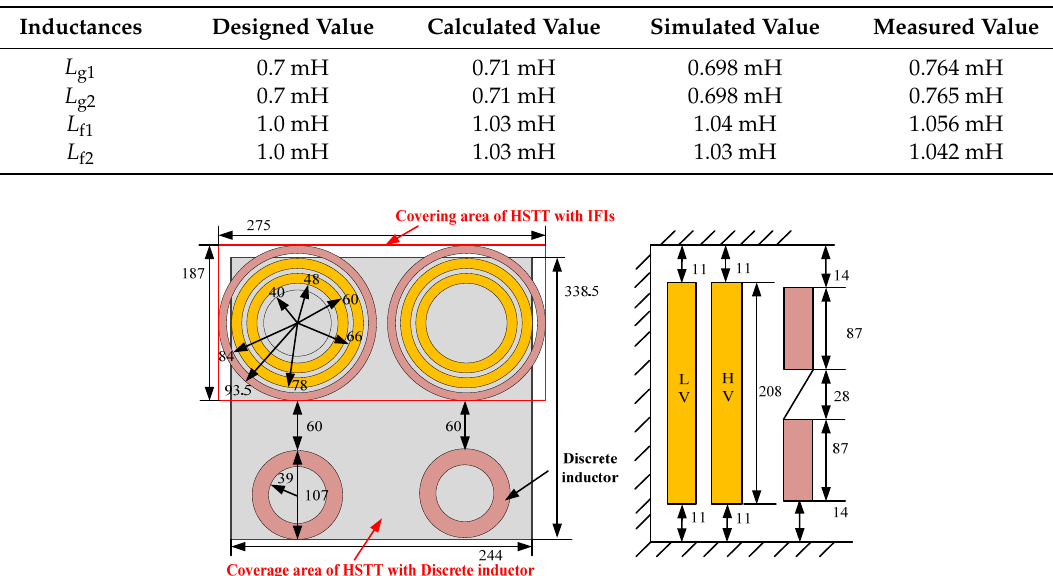
Table 4. Inductances obtained by di ff erent methods.